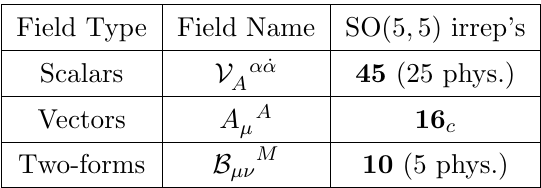
Table 5 . The (bosonic) (cid:12)eld content of maximal supergravity in six dimensions. (cid:22) denotes a spacetime index, A is a MW spinor of SO(5 ; 5), M is an SO(5 ; 5) fundamental index, while (cid:11) & _ (cid:11) denote spinors of the time(space)like SO(5) subgroups of SO(5 ; 5).